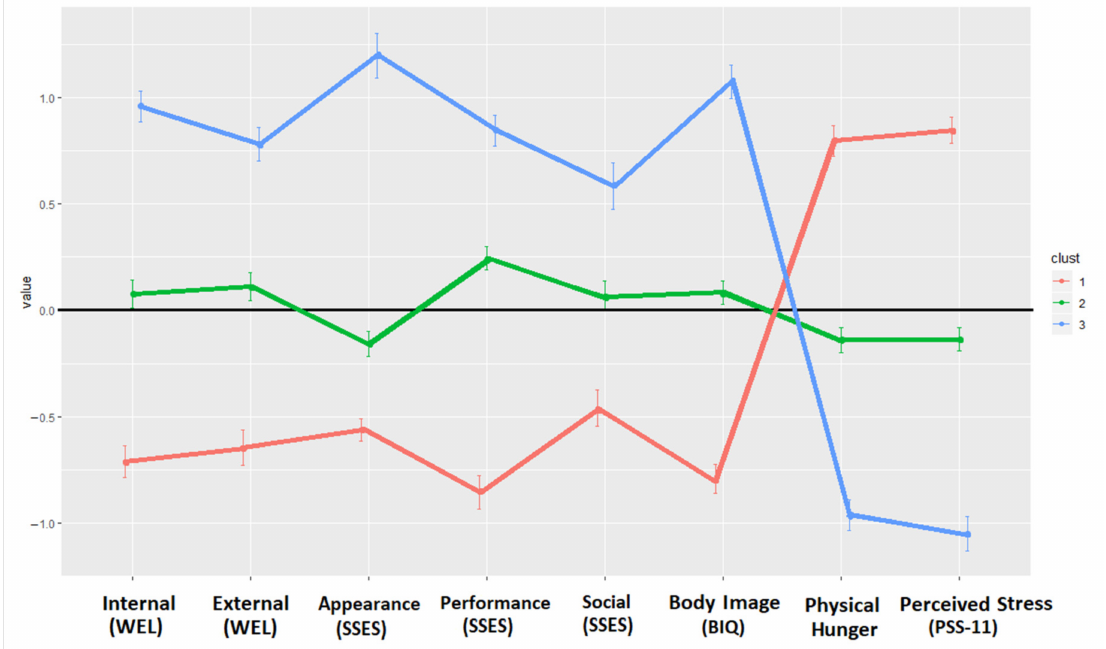
Figure 1. Graphical presentation of the clusters identified in the female subsample. Note. Internal (WEL): Resistance to internal stimuli; External (WEL): Resistance to external stimuli; Appearance (SSES): Appearance state self-esteem; Performance (SSES): Performance state self-esteem; Social (SSES): Social state self-esteem; Body Image (BIQ): Body Image Questionnaire; Perceived Stress (PSS-11): Perceived Stress